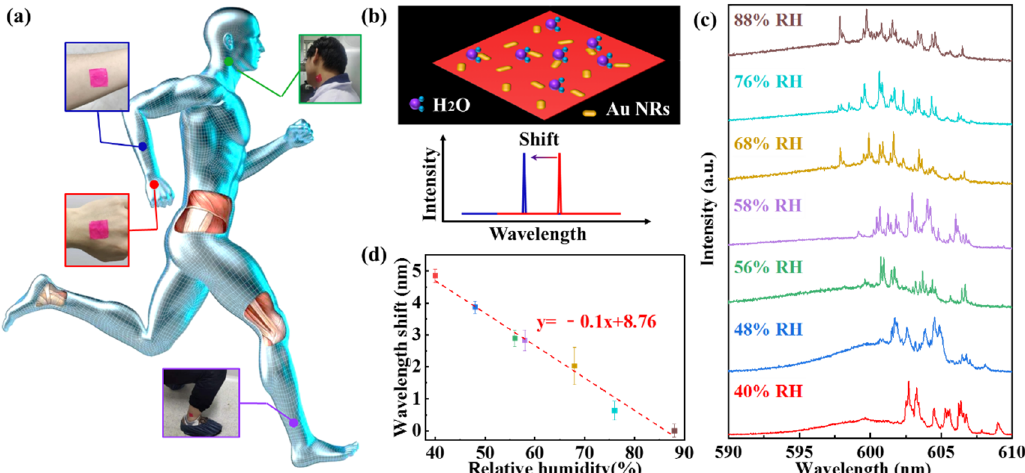
Figure 4. Measurement of small motion signals with polymer film sensors. ( a ) The wearable sensors for on-skin applications. The schematic illustration of the sensor attached to different parts for detecting subtle human motions. ( b ) The schematic diagram of the principle of RH sensing. ( c ) The emission spectra of the random laser under different relative humidities ranging from 40% to 88%. ( d ) Plots describing blue-shifting emission peaks as a function of relative humidity.